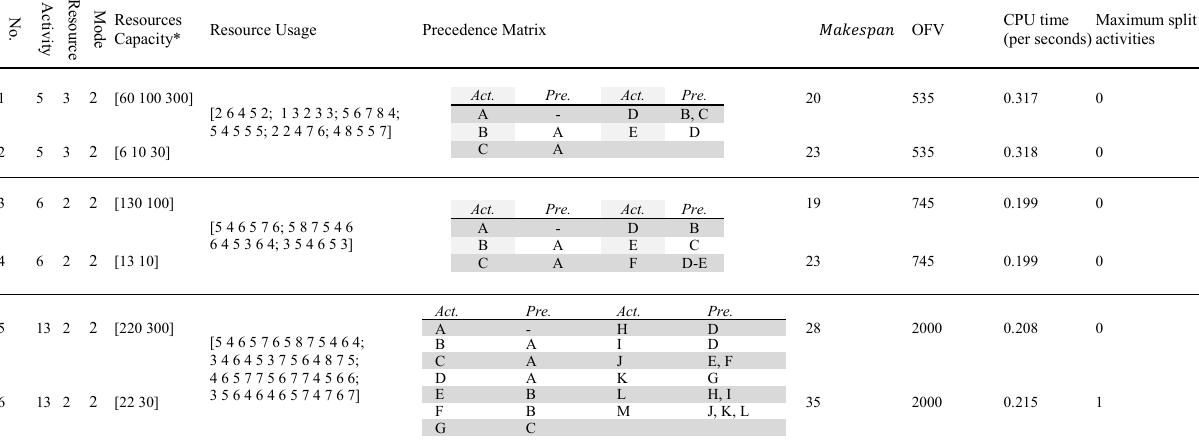
CPU time seconds)Maximum split (per